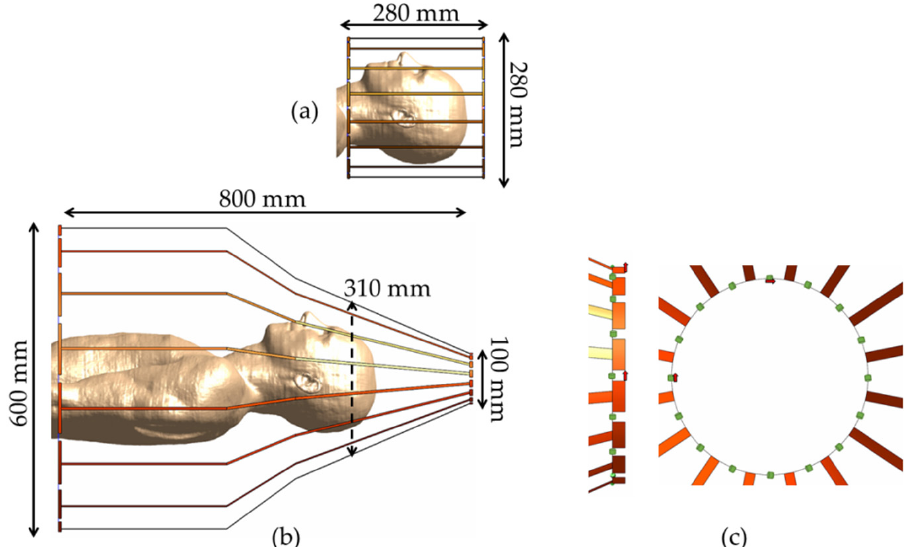
Figure 1. Birdcage (BC) coil geometries in sagittal ( a ) head BC coil, ( b ) yurt BC coil, and ( c ) capacitor placement in the yurt small ring.